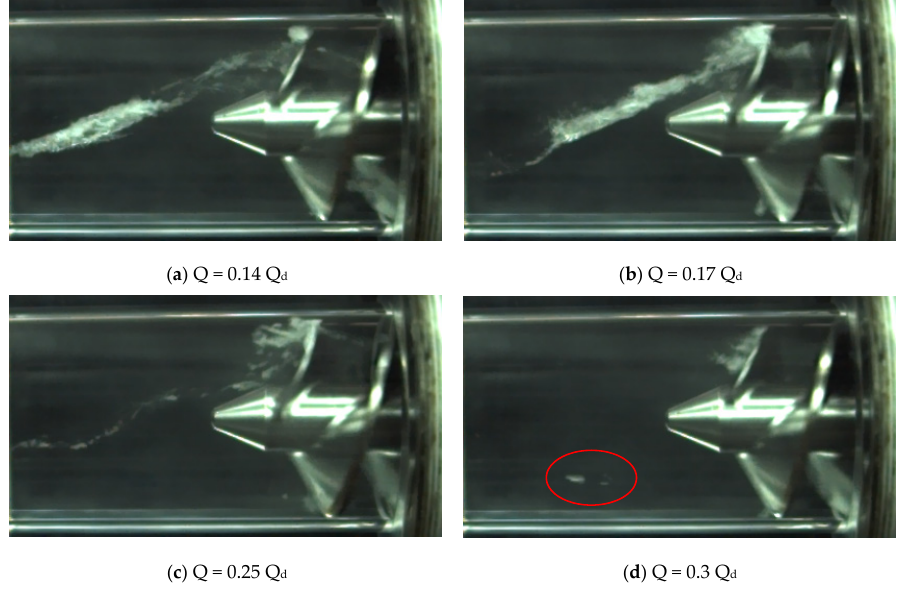
Figure 9. Variation of vortex under NPSH = 10